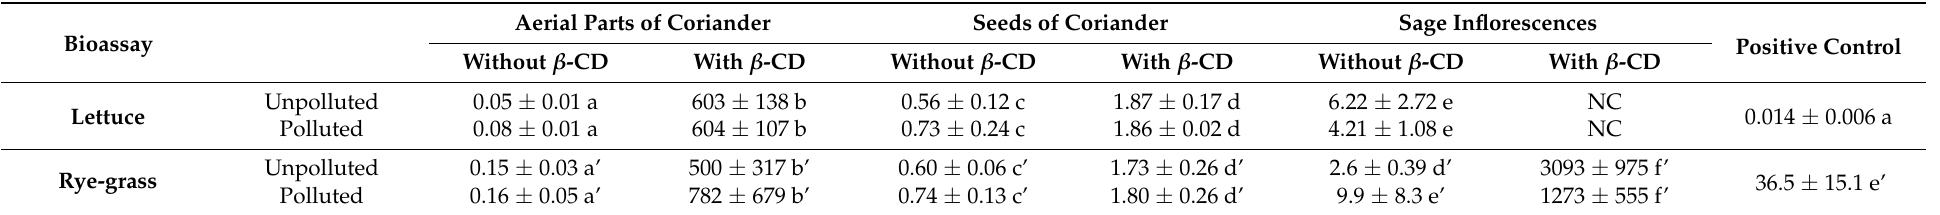
Table 2. EO’s IC 50 (g L − 1 ) resulting from the seedlings’ emergence inhibition bioassay against lettuce and rye-grass. Values are means ± SD (n = 3).